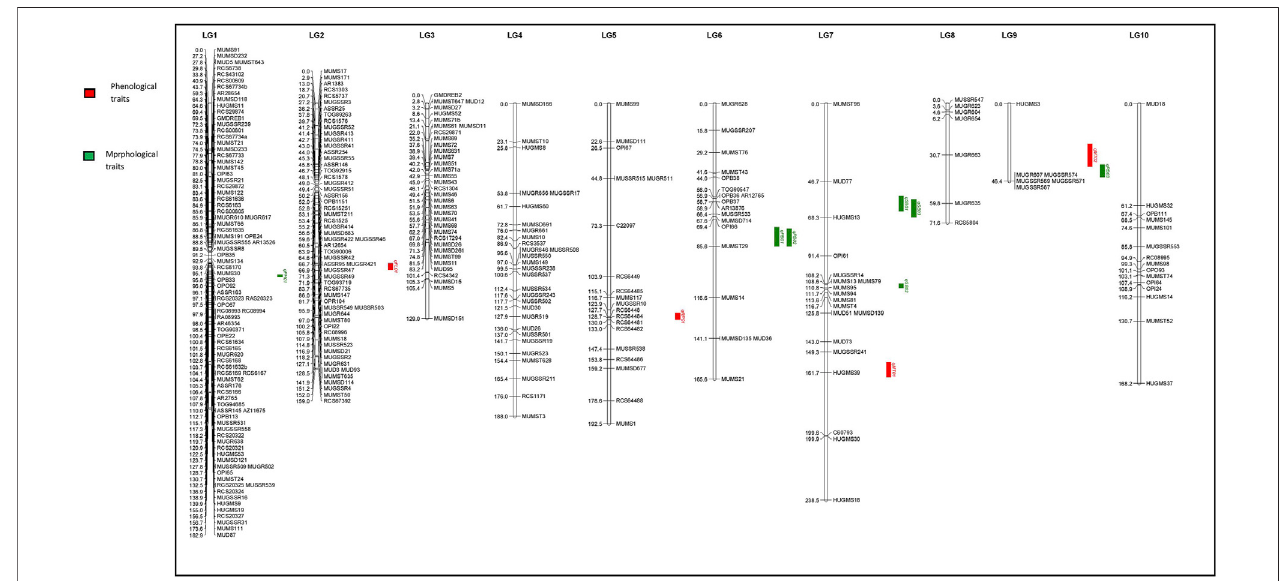
FIGURE 4 | Quantitative trait loci (QTLs) linked to phenological and morphological traits on 10 linkage groups of horsegram (Red color indicates QTLs for Phenological traits; Green color indicates QTLs for Morphological traits.